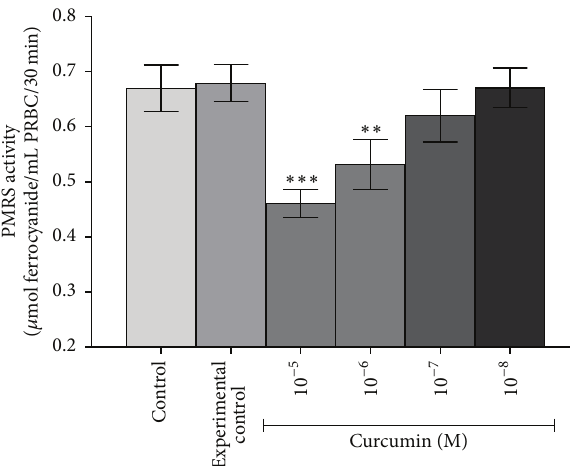
Figure 1: In vitro effects of curcumin (10 −5 M to 10 −8 M) on Wistar rat erythrocytes PMRS activity: PMRS activity expressed in terms of 𝜇 mol ferrocyanide/mL PRBC/30min. Values represent mean ± SD. Control represents erythrocytes receiving no treatment; Experimental control: erythrocytes were incubated with solvent, that is, 0.1% DMSO.